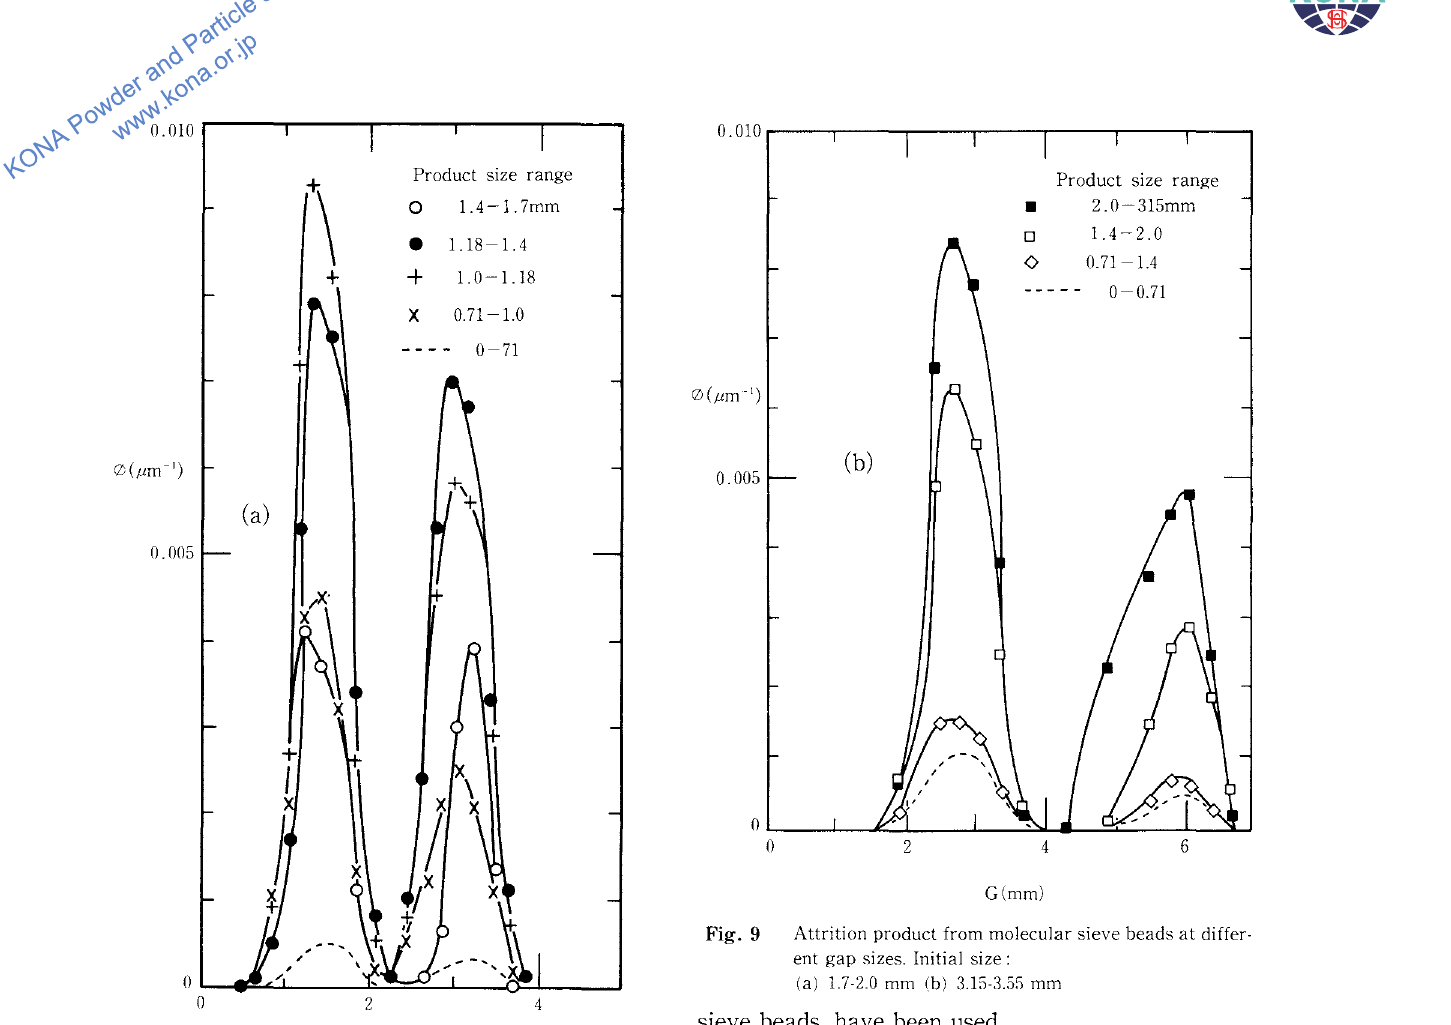
Attrition product from molecular sieve beads at differ ent gap sizes. Initial